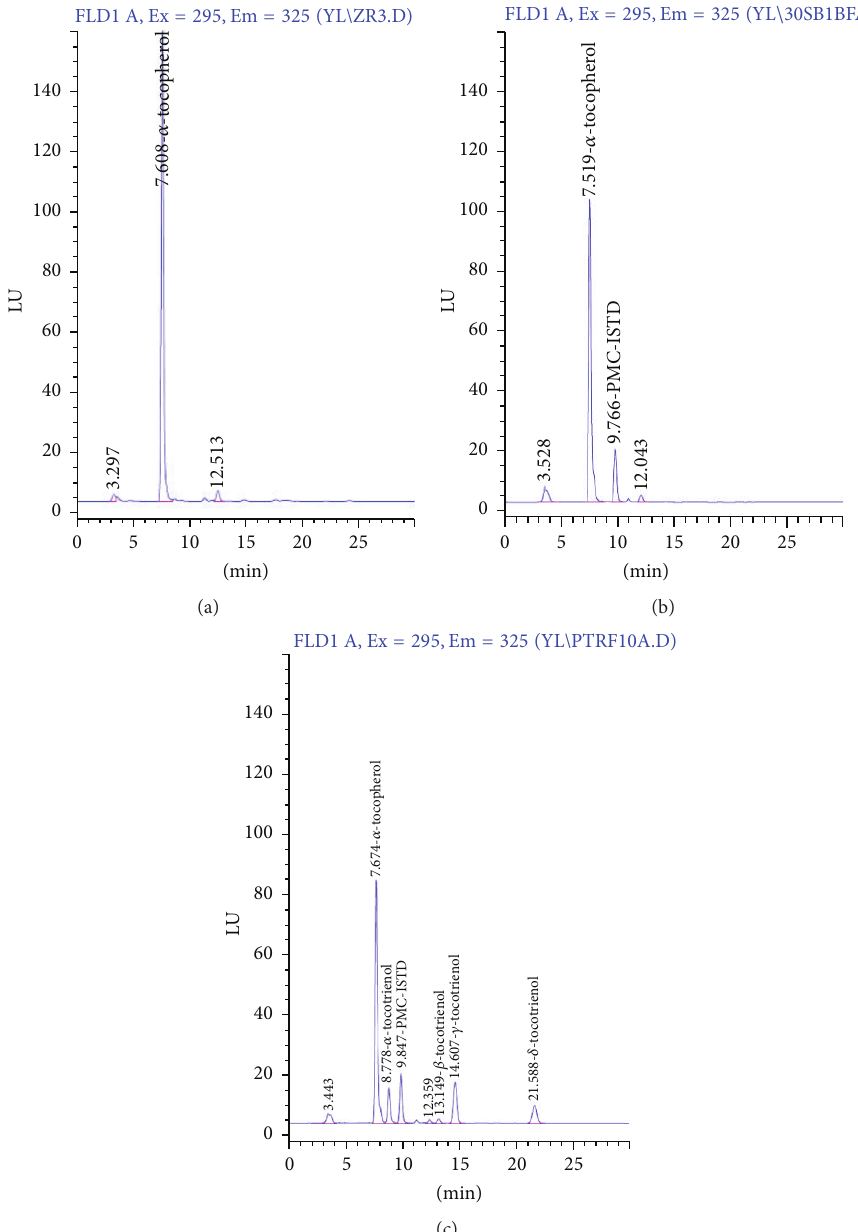
Figure 1: Chromatograms of (a) blank plasma, (b) plasma spiked with IS, and (c) plasma spiked with IS and vitamin E standard.